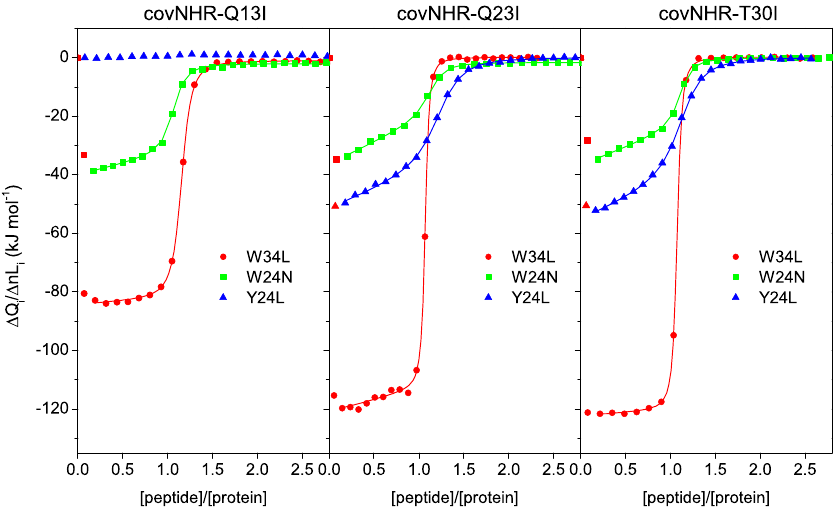
Figure 3. Binding of the covNHR mutants to C-terminal heptad repeat (CHR) peptides. Binding isotherms determined by isothermal titration calorimetry (ITC) for each protein to different peptides as indicated in the figure. The symbols represent the experimental heat normalized per mole of injected ligand, and the curves represent the best fittings obtained with the binding models as described in the text. Therefore, to better estimate the binding affinities, we employed an approach based on DSC, as previously used for covNHR [23], in which we analyzed the protein–peptide mixtures at different molar ratios observing the influence of the thermally induced dis- sociation on the DSC thermograms. Since binding is highly exothermic, dissociation is endothermic and will be forced by heating. The resulting thermograms for the three mutants are shown in Figure 4. Interestingly, due to the extreme stability of the Q13I and Q23I mutants, the peak corresponding to peptide dissociation induced by heating be- comes fully separated from the denaturation transitions of the proteins, which occur at much higher temperatures. In the case of the T30I mutant, the peaks corresponding to peptide dissociation and protein denaturation partially overlap. The curves were globally fitted with a 1:1 equilibrium binding model (N + L ↔ NL) coupled to the Lumry–Eyring denaturation model (N ↔ I → F), as described previously [23]. The binding enthalpy measured by ITC at 25 °C was fixed in the fittings. The resulting binding affinities are detailed in Table 1. Strikingly, the binding constants estimated with this procedure are considerably higher than those estimated by ITC, even up to five orders of magnitude, as it is the case of the Q23I mutant. These dramatic differences are unlikely to be due to experimental errors of the calorimetric experiments, but they likely reflect some type of anomalous binding behavior that is not accounted for by the simple binding models used to analyze the data quantitatively, as discussed later in the paper.